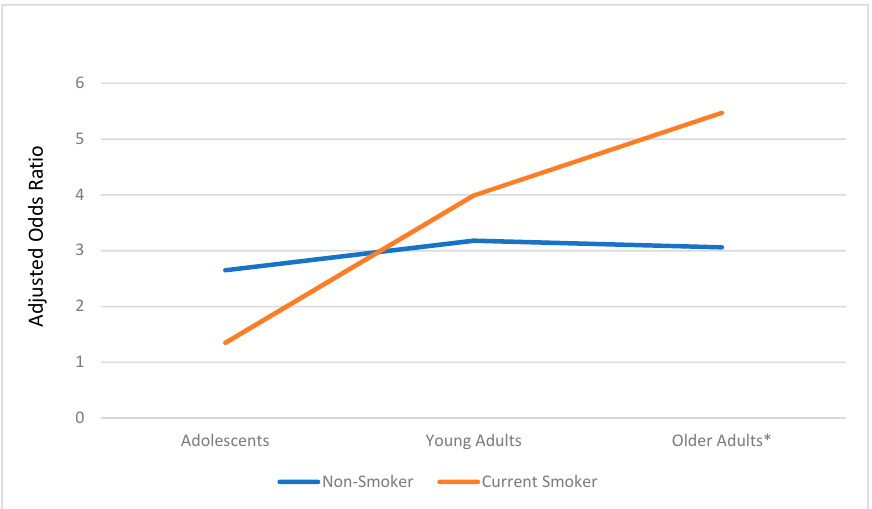
Figure 2. Exposure to e-cigarette advertising: Age group by cigarette smoking status interaction. *: p < 0.001.